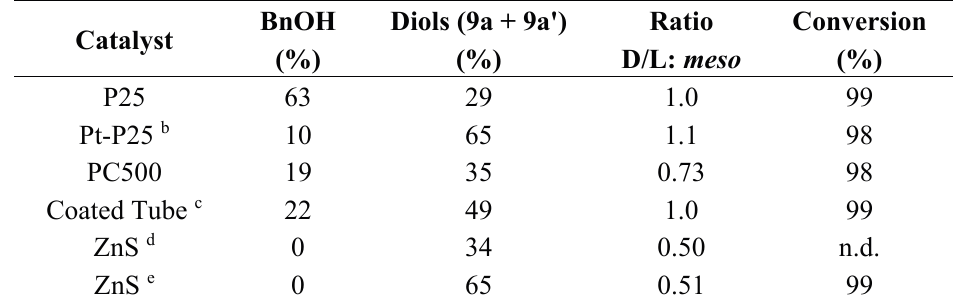
a Yields determined by NMR; b P25 doped with Pt at loading of 0.1% ( w / w ); c NMR tube coated with